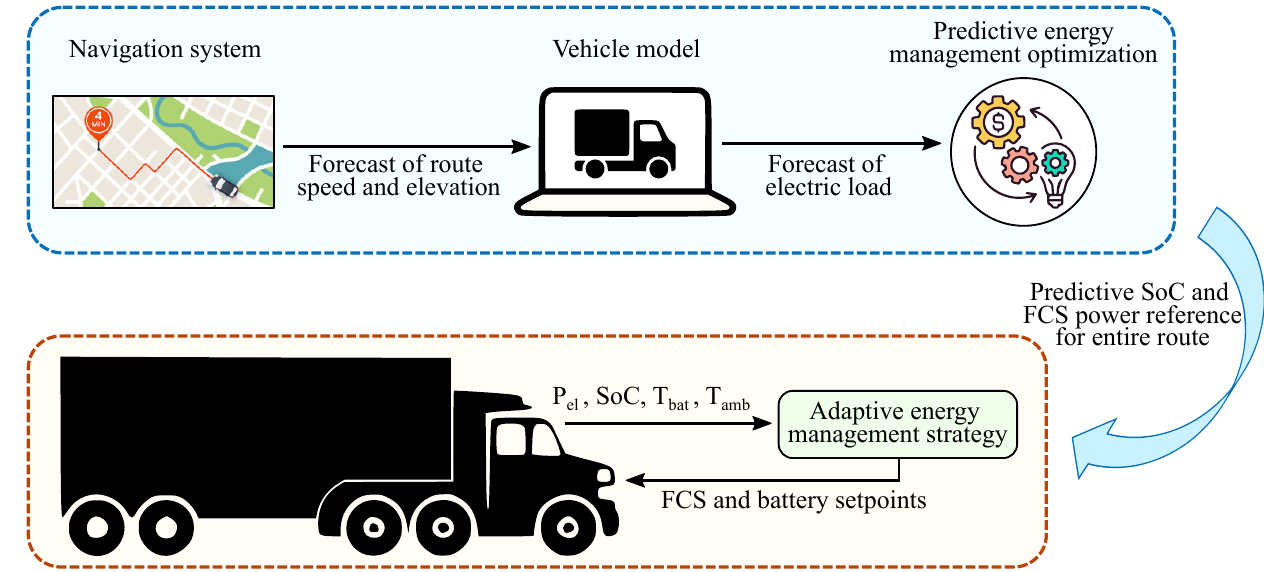
Figure 5. Control architecture of the predictive energy management